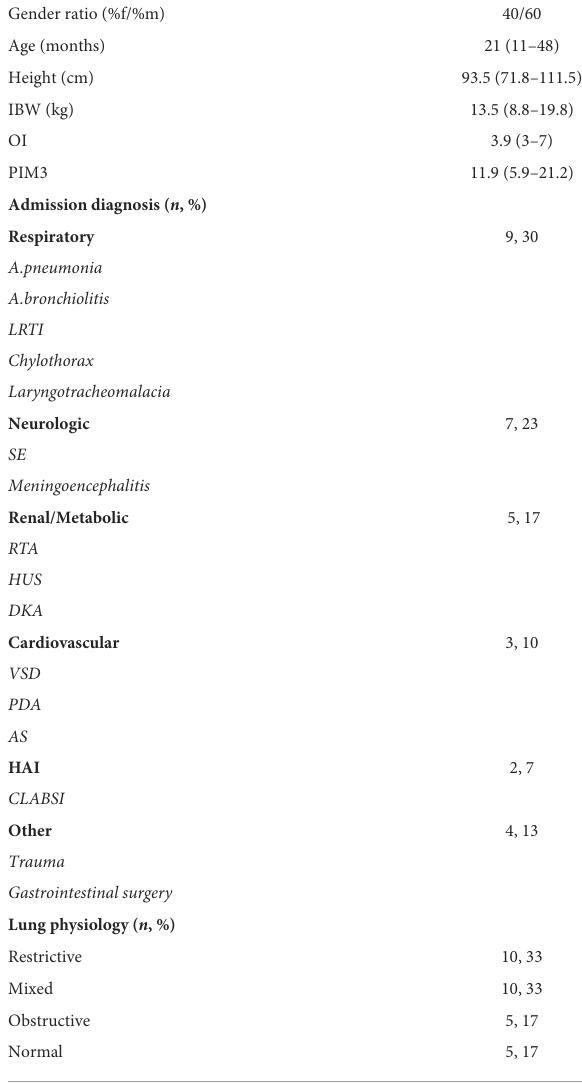
TABLE 2 Baseline characteristics of the